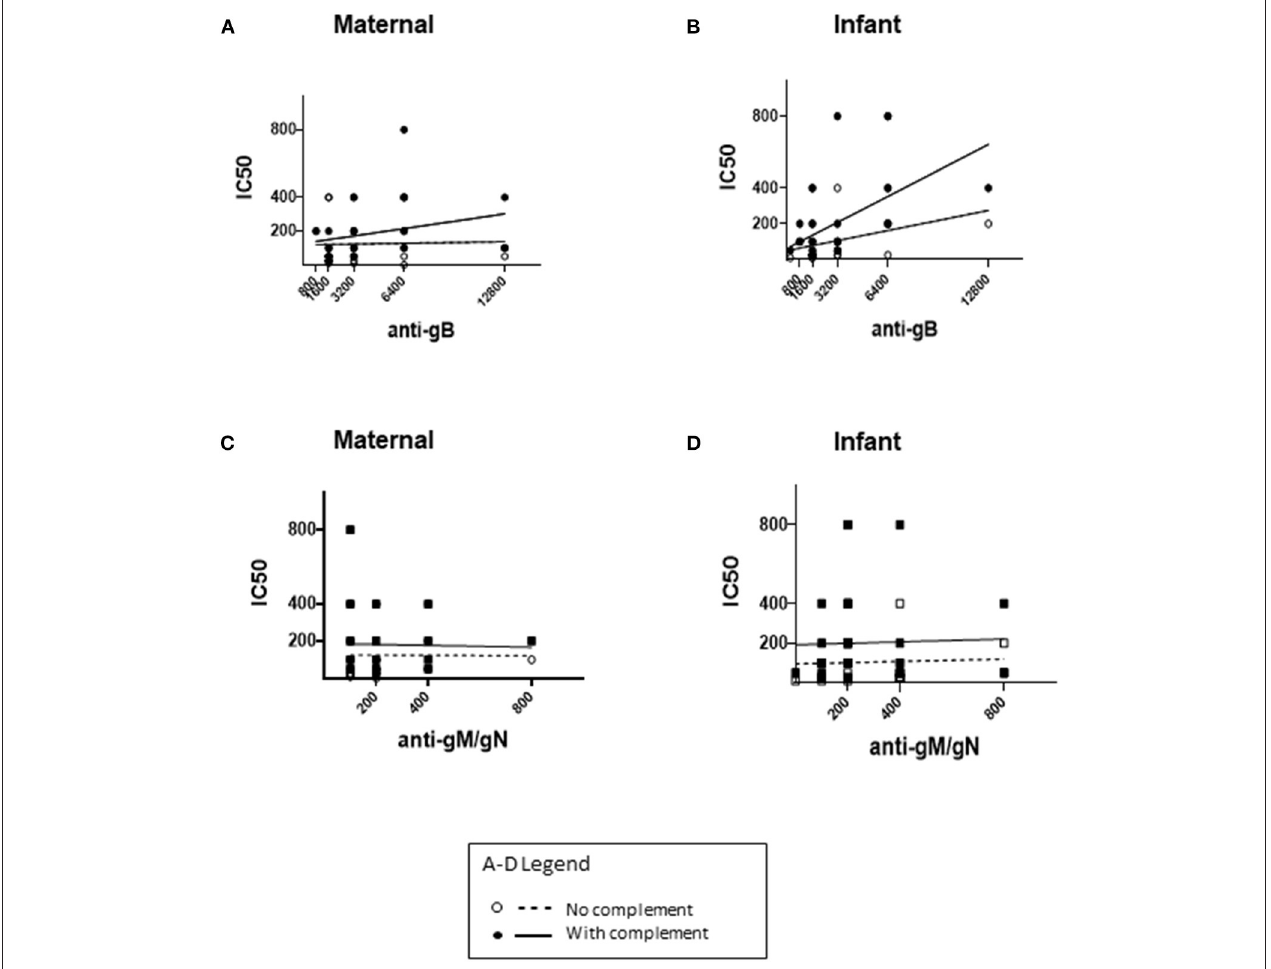
FIGURE 2 | Neutralizing titers of maternal and infant sera. CMV neutralizing capacity of maternal third trimester sera and infant cord sera were tested using an in-vitro neutralizing assay, without or with guinea pig complement, and the IC50 titer was calculated for each sample. The IC50 titers without complement (dotted lines) and with complement (solid lines) were compared to anti-gB and anti-gM/gN titers in maternal (A,C) and infant (B,D) sera. (A,B) The x-axis range reflects anti-gB titers ranging from 1:200-1:12800. (C,D) The x-axis range reflects anti-gM/gN titers ranging from 0–1:800 (A–D) . For each correlation plot, a single circle/square may represent more than one sample with the antibody titer/neutralizing IC50 titer shown in each